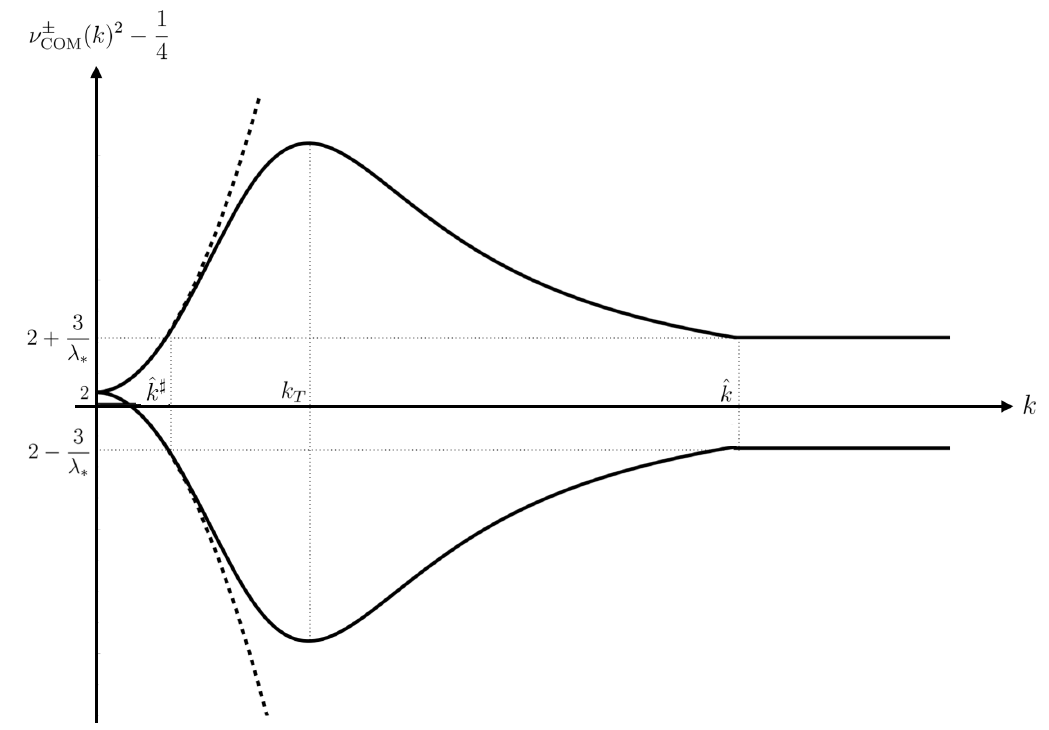
( k ) 2 − 1 (upper graph) and ν − COM 4